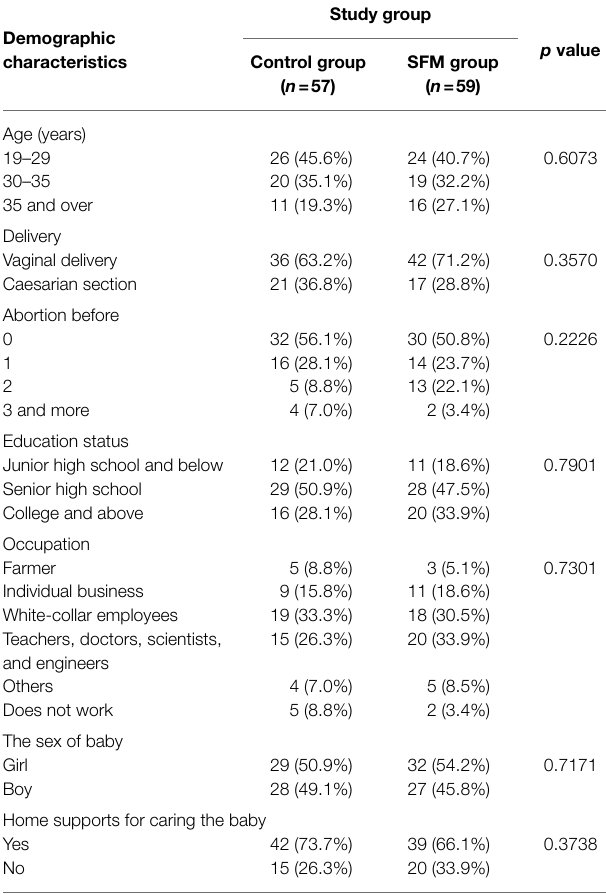
TABLE 1 | Characteristics of analyzed participants.